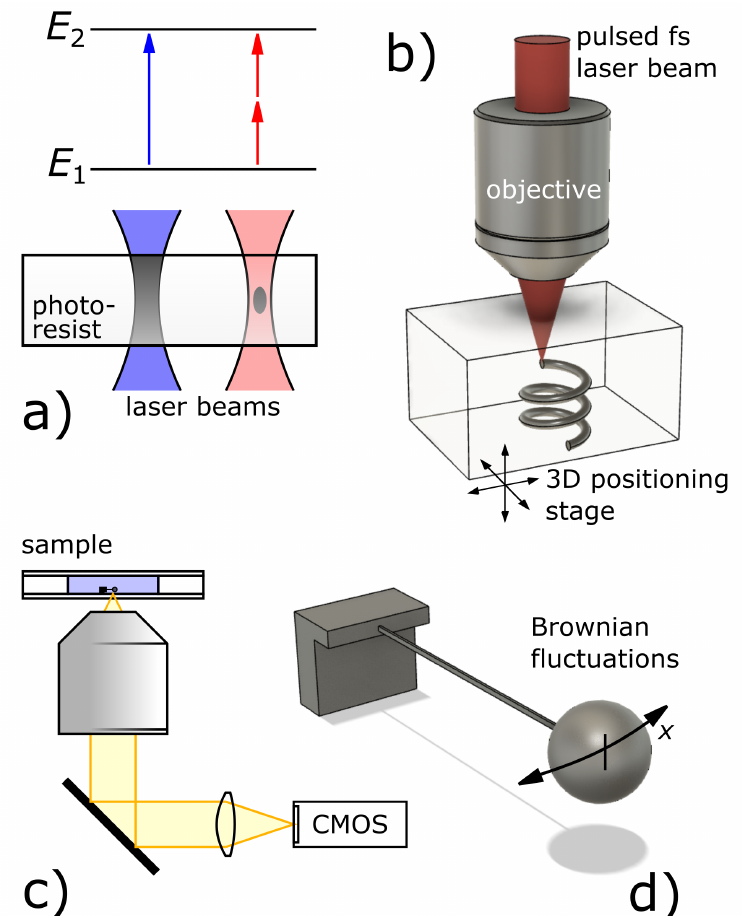
Figure 1. The main steps from sample preparation to measurement. ( a ) Light-sensitive (photoresist) material exposed to the laser beam. Single photon (left part, in blue) and two-photon (right part, in red) polymerization is depicted separately. (The exceptional spatial resolution can be reached by the two-photon process. The polymerized material is indicated in gray.) ( b ) The illumination used to produce three-dimensional design in the photoresist volume employing TPP-DLW. ( c ) Setup for motion detection and data production. The application of a CMOS image sensor, which provides encoded light information about position x ( t ) that can be converted into digital data records by particle tracking algorithms. ( d ) A closer look at the mechanics of Brownian fluctuations under anchoring conditions. The studied fluctuations in the horizontal plane are indicated by the